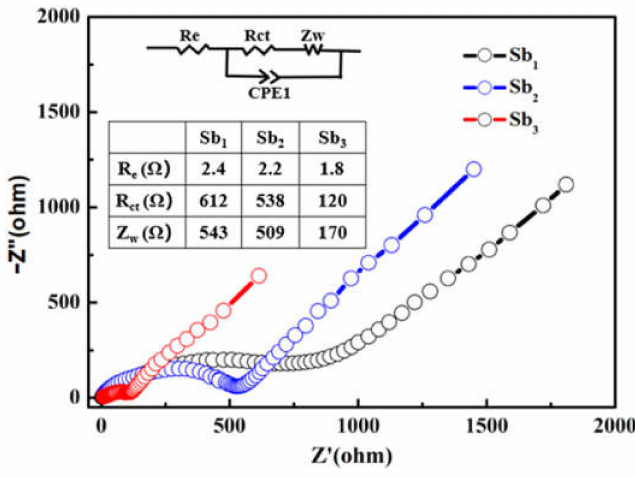
Figure 6. Nyquist plots of the Sb 1 , Sb 2 and Sb 3 .